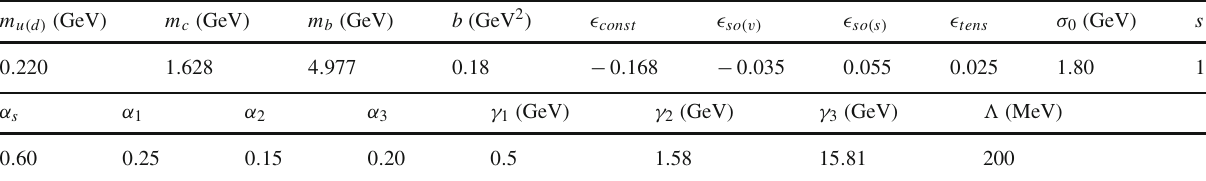
Table 1 The values of the